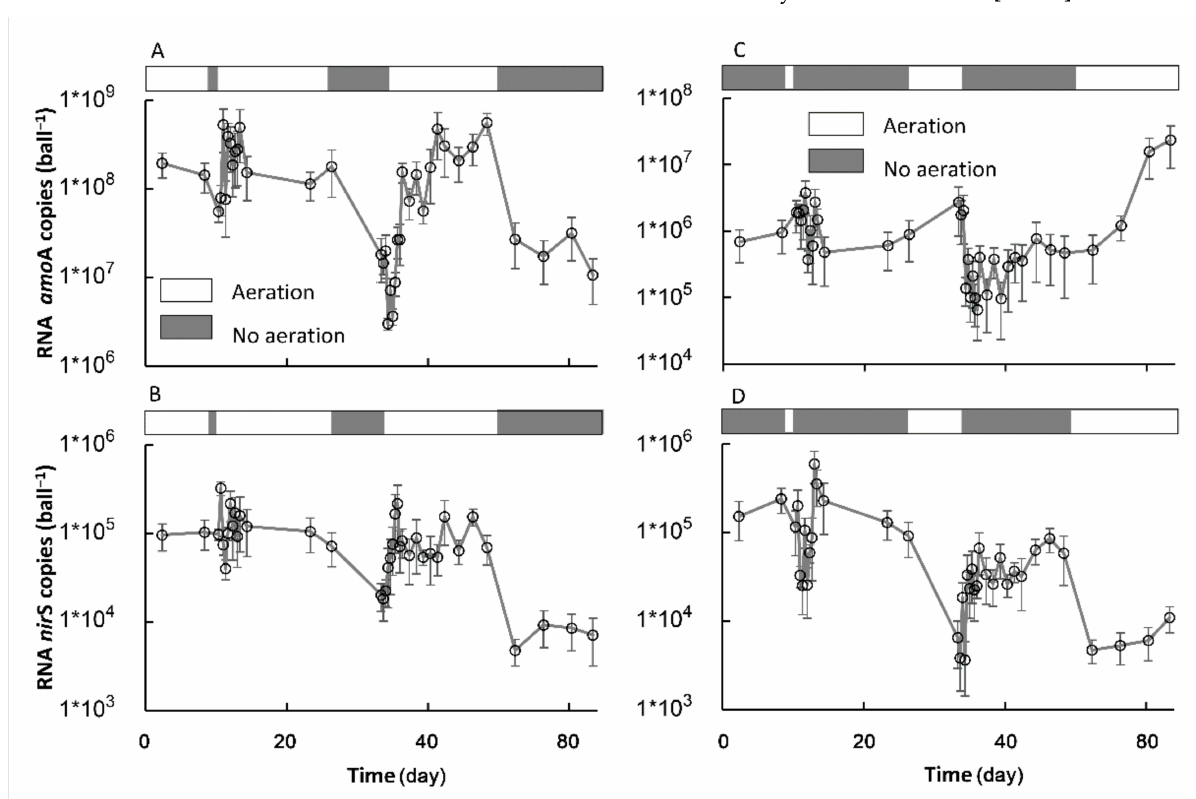
Figure 8. The fluctuations in the abundance of nitrogen-cycle functional genes amo A and nir S at the RNA level with the transformation between aeration and no aeration in the AE-D ( A , B , respectively) and AN-D reactors ( C , D , respectively) (sample number: